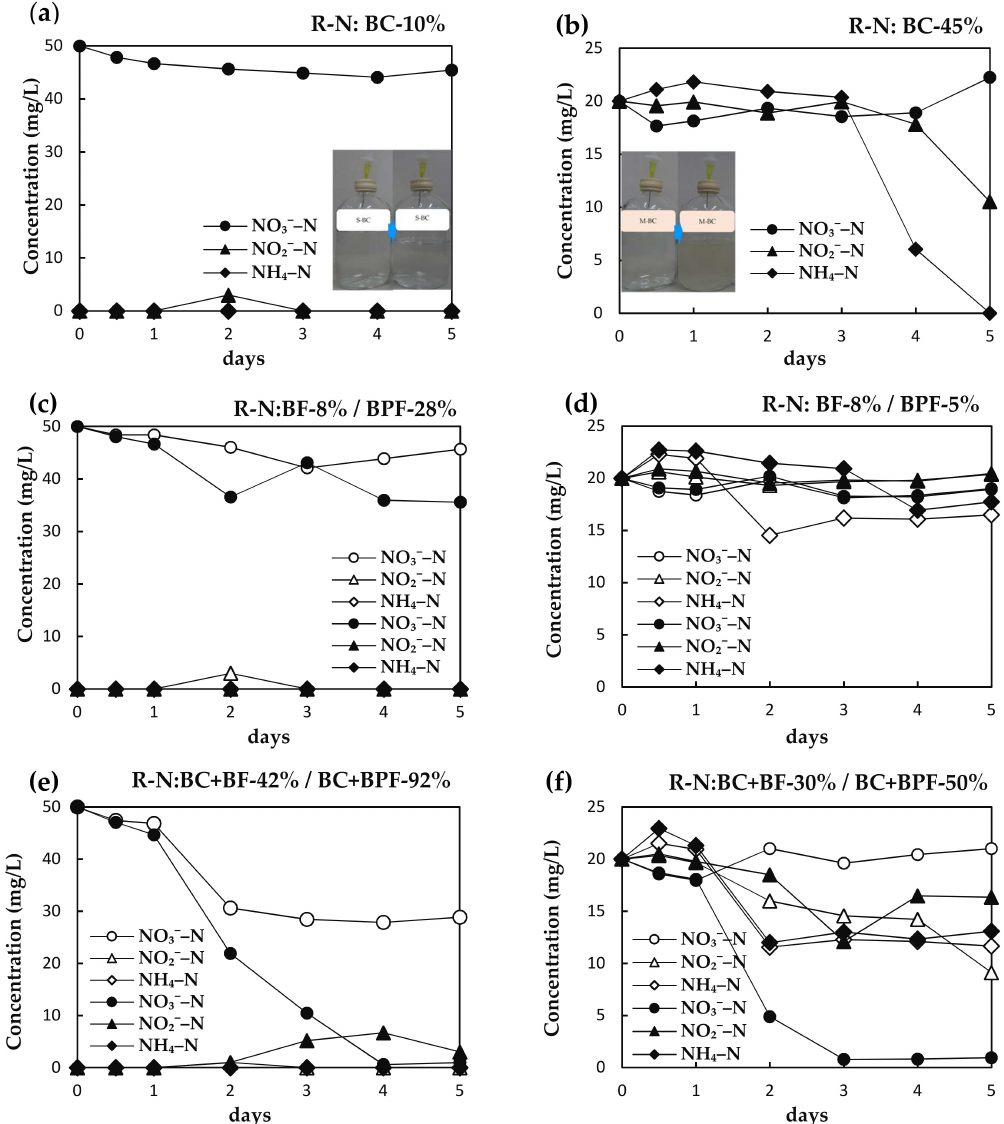
Figure 1. The aerobic nitrogen removal efficiency: ( a ) BC in a single nitrate reactor; ( b ) BC in a mixed nitrogen reactor; ( c ) BF; the open symbols and BPF; the closed symbols in a single nitrate reactor; ( d ) BF; the open symbols and BPF; the closed symbols in a mixed nitrogen reactor; ( e ) BC + BF; the open symbols and BC + BPF; the closed symbols in a single nitrate reactor; ( f ) BC + BF; the open symbols and BC + BPF; the closed symbols in a mixed nitrogen